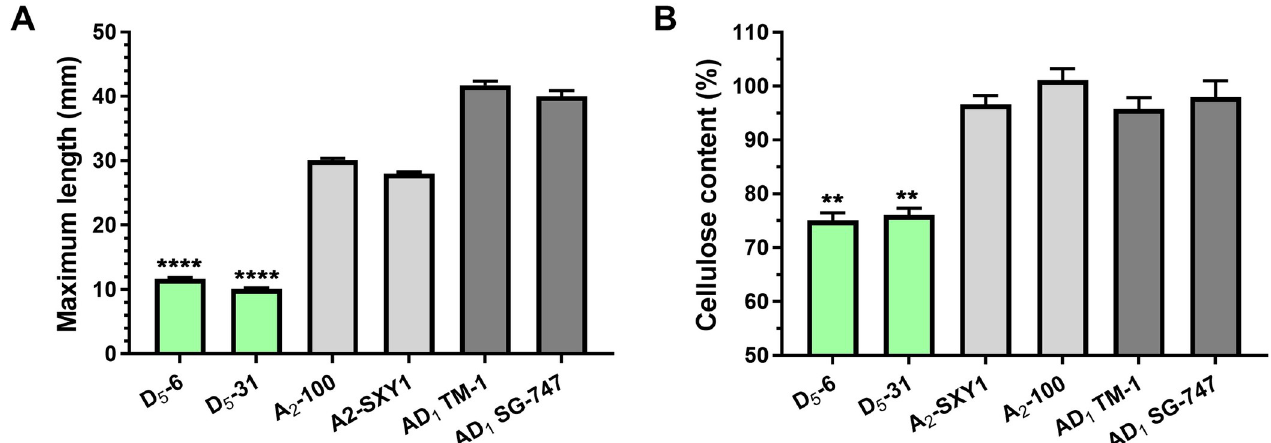
Fig 2. Fiber phenotypic variations between wild diploid G . raimondii and two cultivated cotton species (1 st set). A. Maximum fiber length. Fiber length was manually measured from cottonseeds of wild G . raimondii (D 5 -6 and 31), cultivated G . arboreum (A 2 -100 and SXY1), and cultivated G . hirsutum (TM-1 and SG-747). B. Cellulose content. The error bars represent standard deviation. �� p value < 0.01; ���� p value < 0.0001.